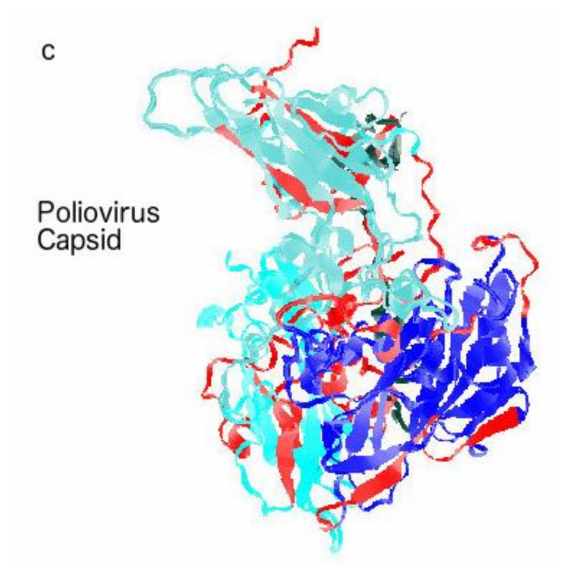
Figure 3. Crystal Structures with Disorder Annotated in Red. ( a ) A highly disordered HIV matrix (1hiw.pdb). ( b ) A highly ordered EIAV matrix (1hek.pdb). ( c ) Complex of poliovirus capsid proteins (1p02.pdb). The varying non-red colors in each sample denote di ff erent chains. The Protein Data Bank (PDB) structures without disorder annotations are available at: http: // www.ncbi.nlm.nih.gov / structure /